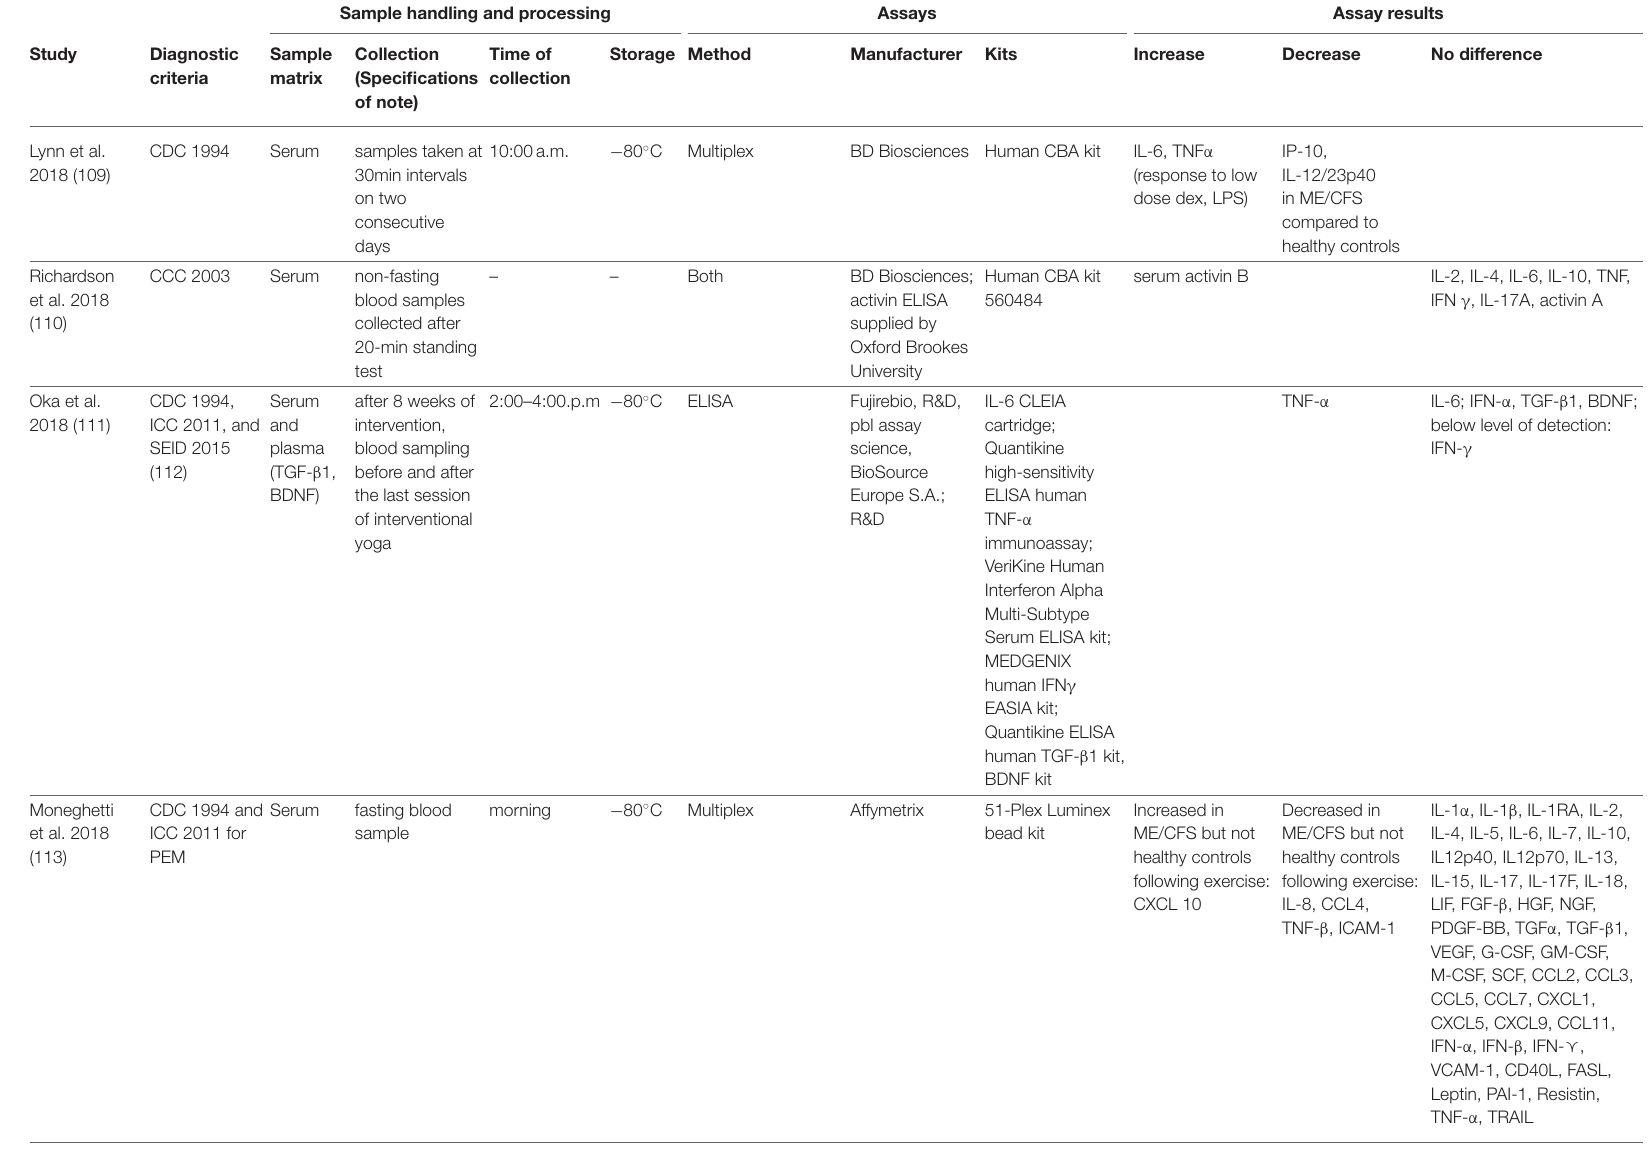
TABLE A1 | Cytokine studies of